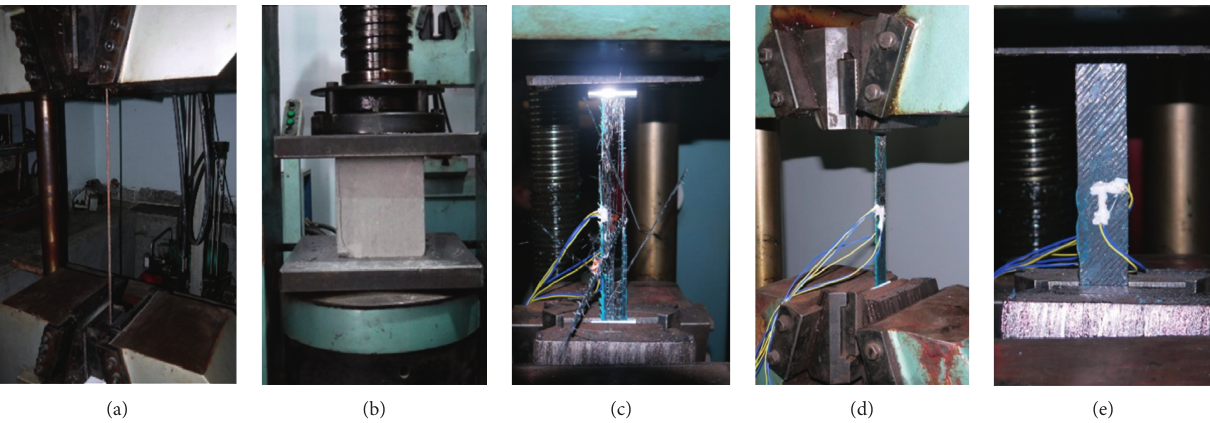
Figure 3: Tested materials coupons. (a) Steel bar tensile test. (b) Cube uniaxial compression. (c) Longitudinal direction. (d) Transverse direction. (e) In-plane